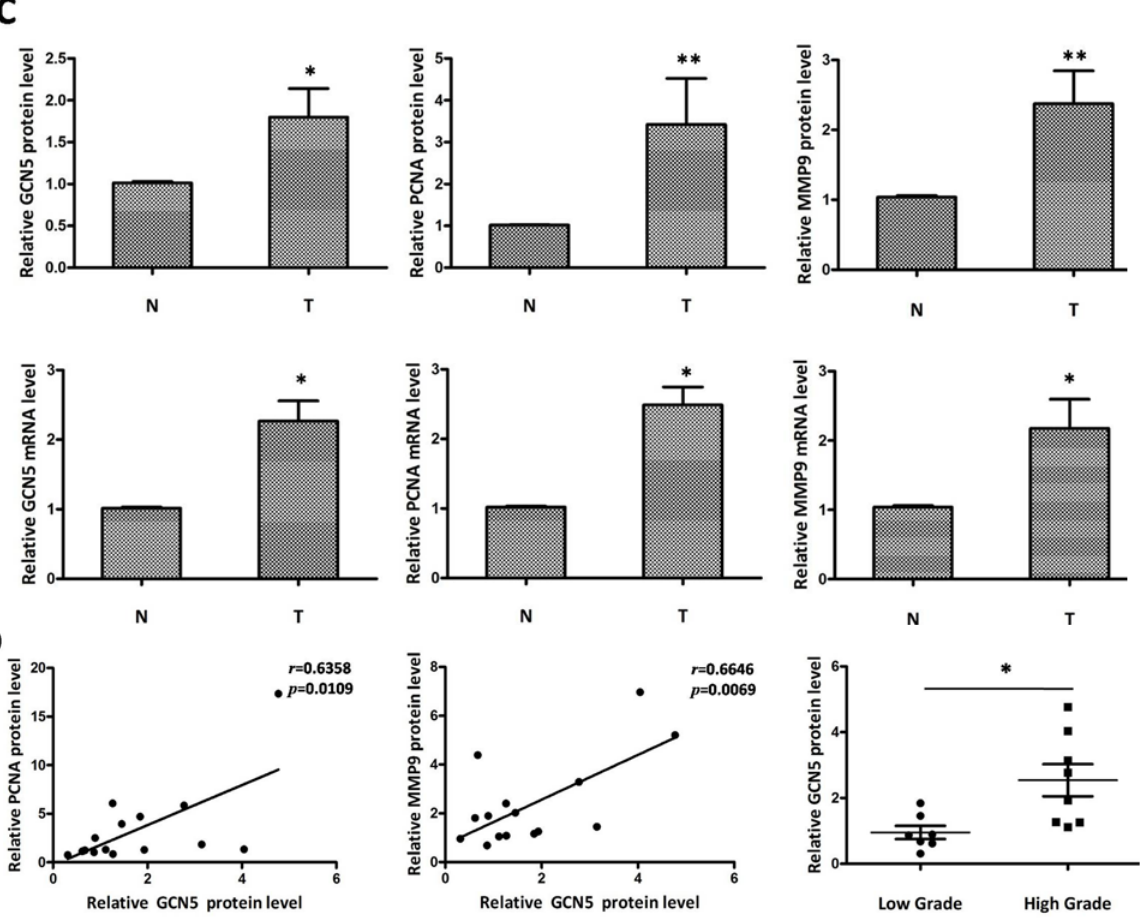
Figure 1. GCN5 was frequently overexpressed in human glioma tissues. ( A ) Glioma and adjacent non-tumor tissue were pathologically diagnosed by HE staining; GCN5 expression in gliomas was determined by IHC (Magnification ×200); ( B ) GCN5, PCNA and MMP9 protein level were determined in 15 (Number1-15) pairs of glioma tissues by Western blot (N: Non-tumor tissue; T: Tumor tissue); ( C ) GCN5, PCNA and MMP9 were overexpressed in glioma tissues compared with adjacent non-tumor tissues both at protein and mRNA level; and ( D ) GCN5 protein level was positively associated with PCNA and MMP9 level, respectively; GCN5 protein level in high-grade group was much higher than in low-grade group tissues (* p < 0.05; ** p <